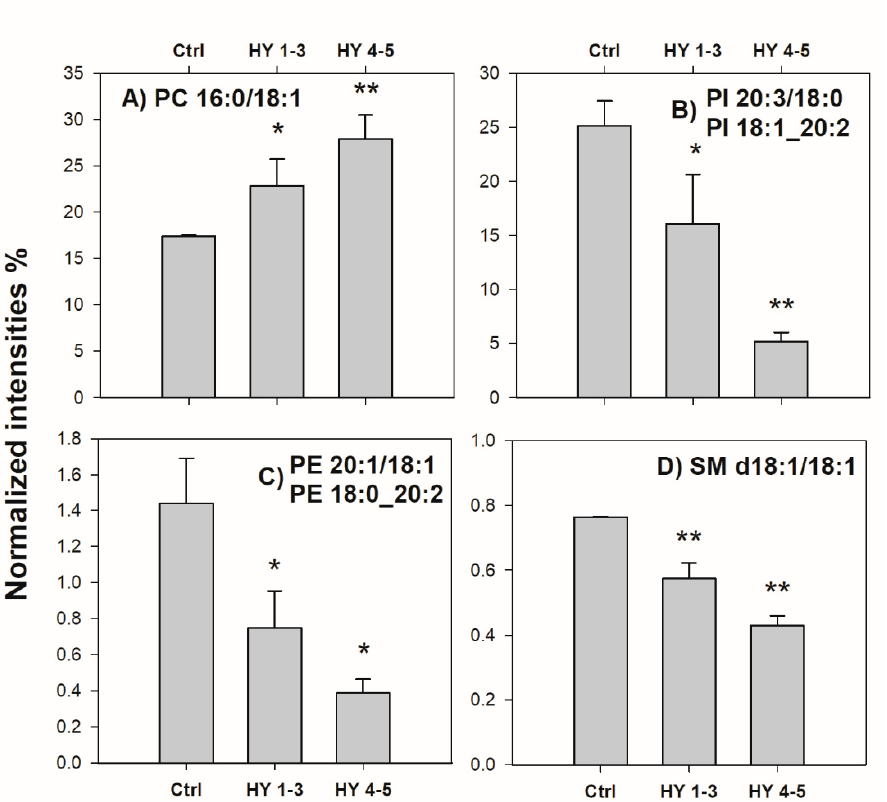
Figure 3. Bar plots of ( A ) PC (16:0 / 18:1), ( B ) PI (20:3 / 18:0) and (18:1_20:2), ( C ) PE (20:1 / 18:1) and (18:0_20:2), and ( D ) SM (d18:1 / 18:1) obtained as normalized intensities (as described in the text) plotted versus pathology degree specified as ctrl (control), group HY 1–3 and group HY 4–5 (see Table 2). Data are reported as average values on three independent replicates for each sample; error bars represent standard deviations. Bars marked with asterisks represent normalized intensities significantly di ff erent from those of control group (* p < 0.05; ** p < 0.01), as assessed using a nonparametric Welch’s two tails t -test.